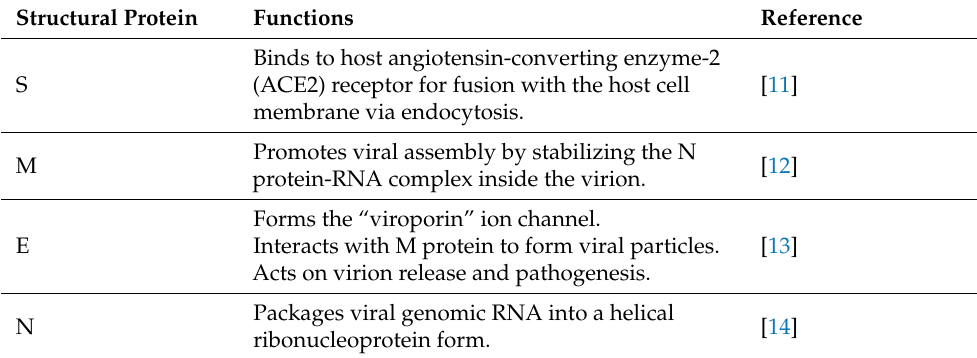
Table 1. Summary of the structural proteins of SARS-CoV-2 and their functions. Structural Protein Functions